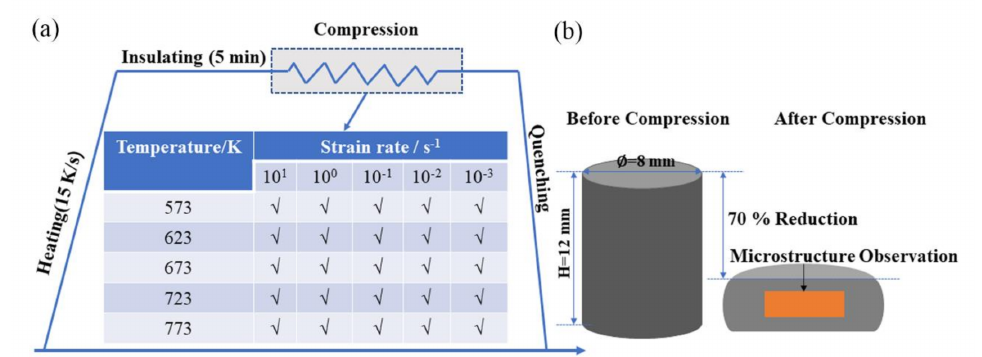
Figure 1. Diagram of the isothermal compression process. ( a ) experimental process; ( b ) EBSD